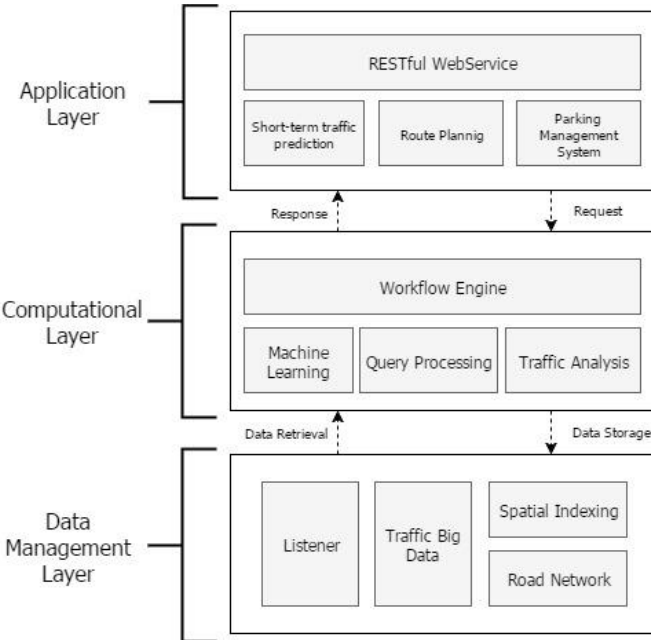
Figure 1. Proposed framework